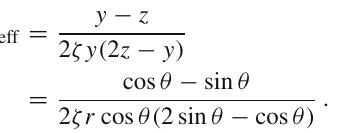
Table 4 This Table exhibits the values of the deceleration parameter q , jerk parameter j and snap parameter s for the physically-relevant con- figurations listed in Table 1. We refer to the main text on details about the mathematical steps involved in these computations. We remark that